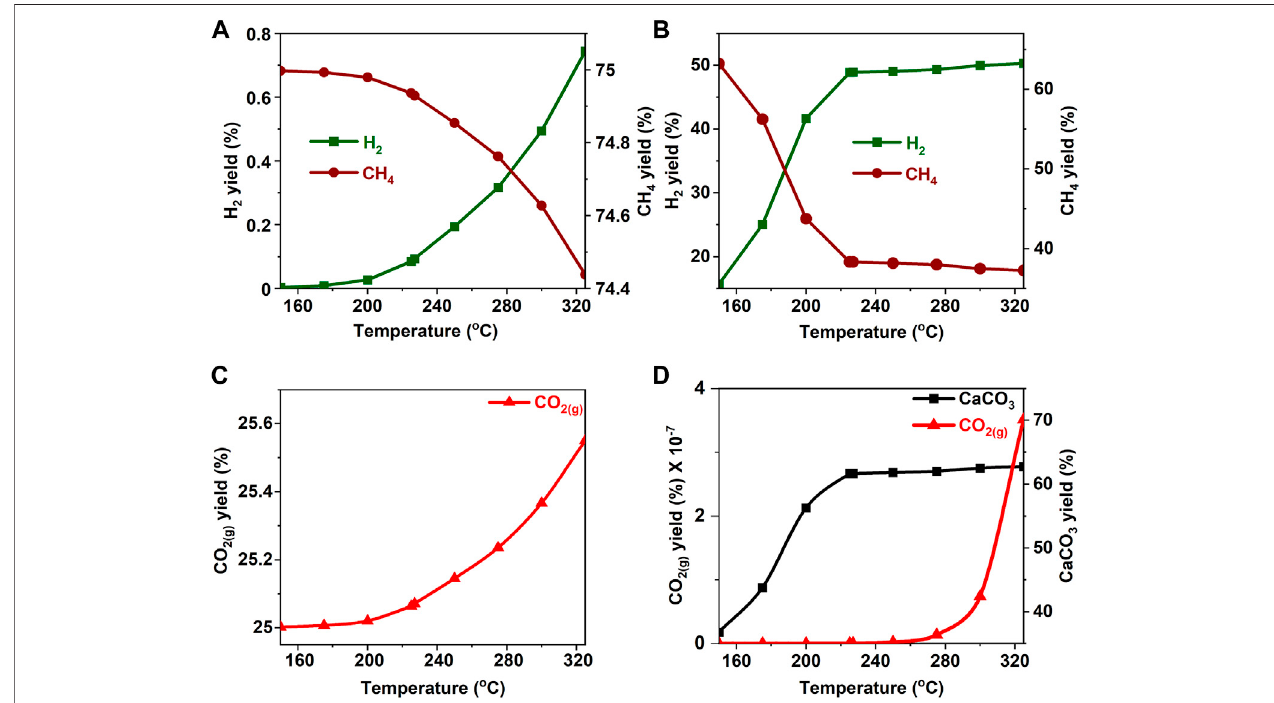
FIGURE10| Effectoftemperatureontheproductyieldfromethanol (A , C) intheabsenceand (B) inthepresenceofcalciumoxide.TheyieldofCO 2 postcaptureto produce calcium carbonate is represented in 8 (D) . These calculations are performed with temperatures of 227 ° C and pressures of 50 bar.